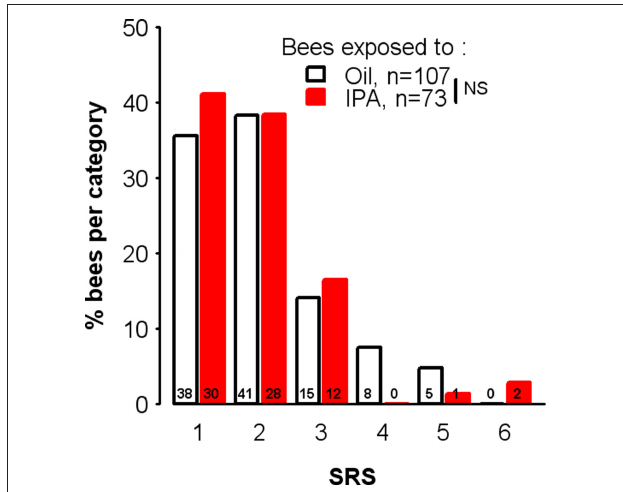
Figure 7 | Learning impairment after iPA exposure is not due to decreased sucrose responsiveness. Distribution of bees exposed to isopentyl acetate ( IPA ) or mineral oil ( Oil ) according to SRS (sucrose response score) values. Unconditioned responses elicited by sucrose were assessed, using 6 sucrose solutions of increasing concentrations (0.1, 0.3, 1, 3, 10, and 30%, in water). For each animal, the presence or absence of a PER was recorded for each concentration, and its individual SRS was calculated as the number of stimuli eliciting a PER (e.g., SRS = 3 for an individual responding to 3, 10, and 30% sucrose but not to lower concentrations). The number of bees with a given value in each group is indicated by the number on each bar. Among bees showing motivation to respond to sucrose, no difference was found between the two groups ( χ 2 = 3.68, df = 3, p = 0.30; bees with SRS values higher than three were grouped in a single category to allow the use of the chi-square test, see Materials and Methods). NS: